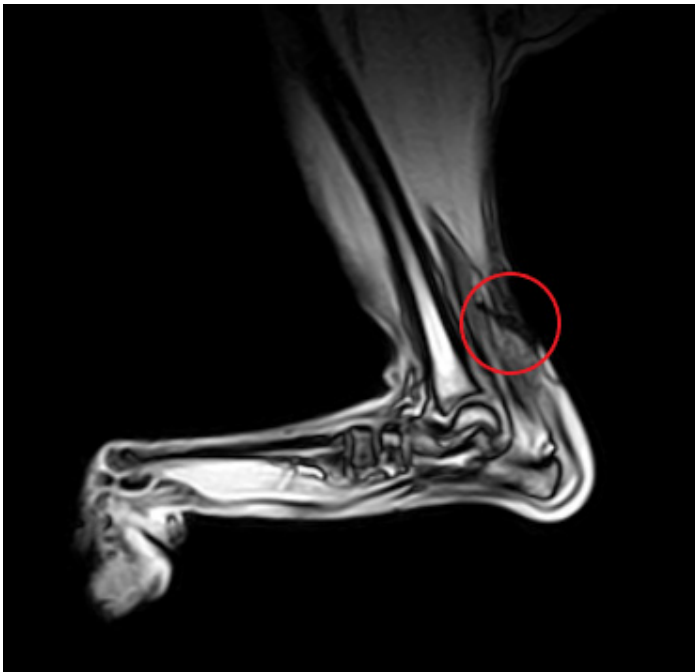
Figure 5. MRI GE T1-weighted image of a partial Achilles tendon rupture (circle). Surgical treatment is generally recommended for veterinary patients, in contrast to human medicine, where Achilles injuries are often managed conservatively. Numerous surgical techniques have been described, most involving primary suture repair with